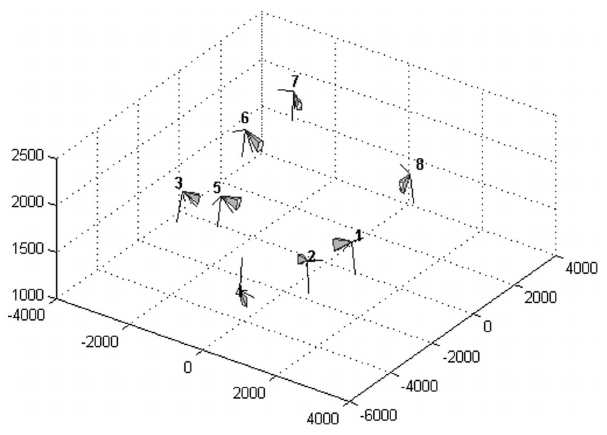
Figure 1. Cameras’ position as resulting from extrinsic calibration. X, Y, Z axis are represented and each camera coordinates along axis are reported in [mm]. Each camera is identified by a number. Orange crosses correspond to additional infra-red illuminators that were not employed in visual hull reconstruction procedure.